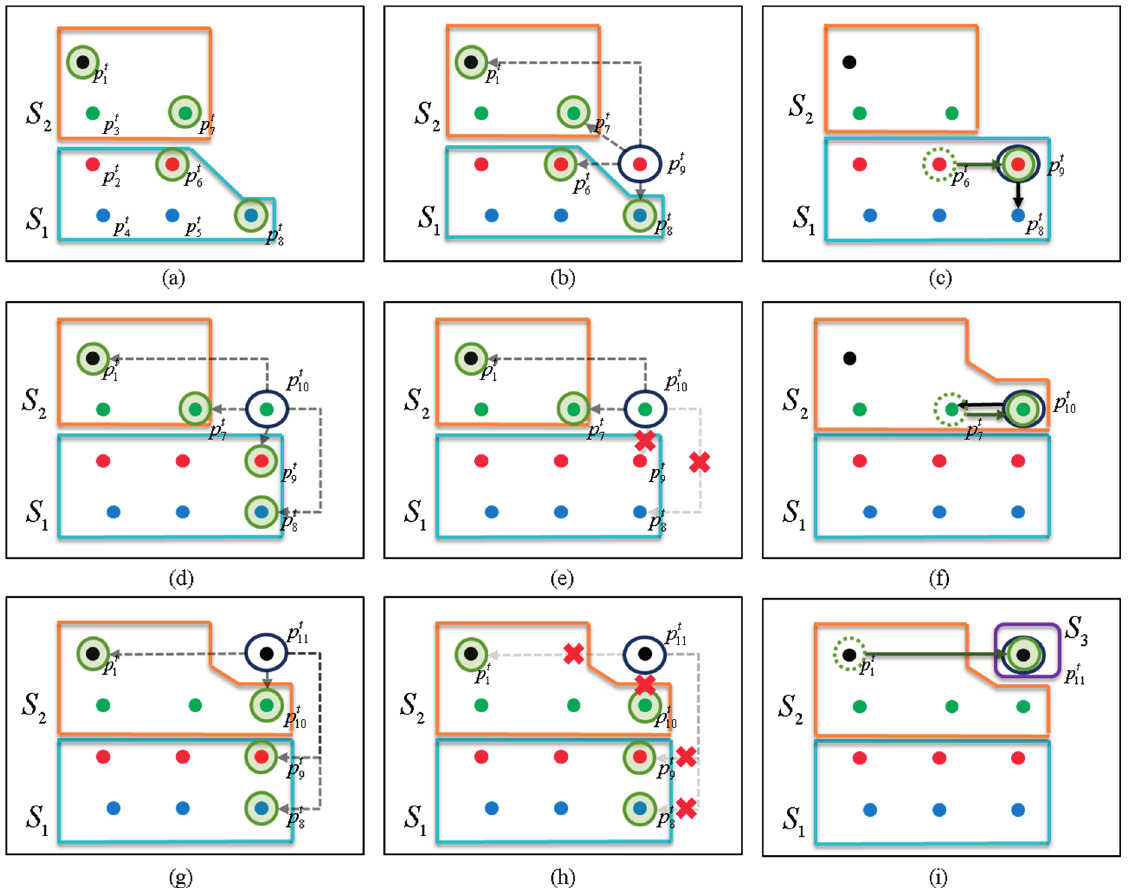
Figure 6. ABD segmentation for multi-layer laser